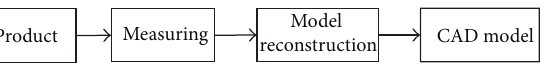
Figure 1: Traditional reverse